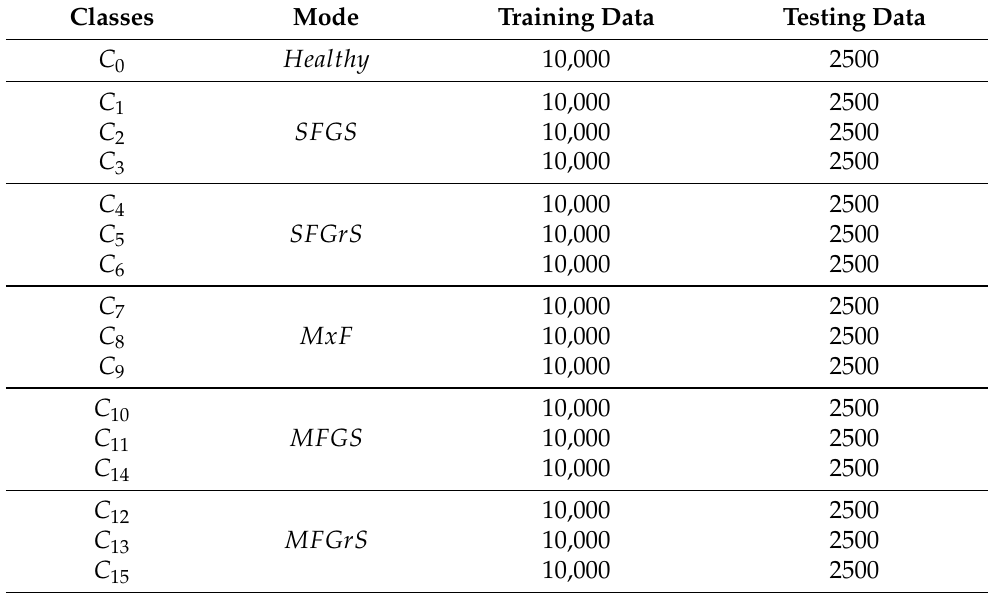
Table 5. Creation of database for fault diagnosis